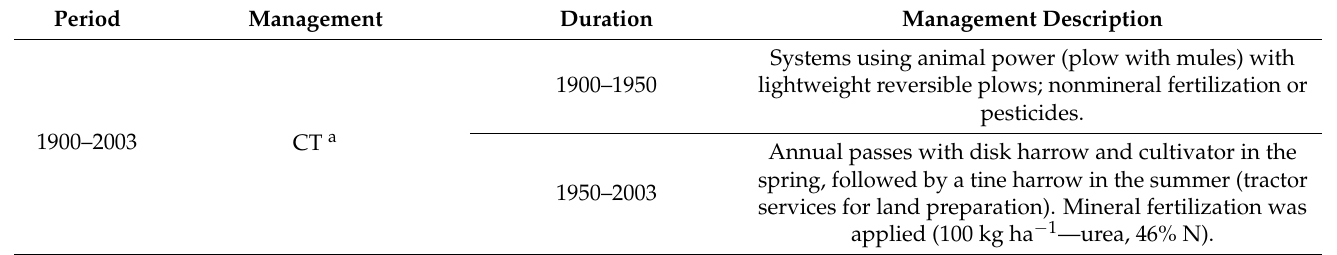
Table 2. Land management, periods, and duration on the experimental